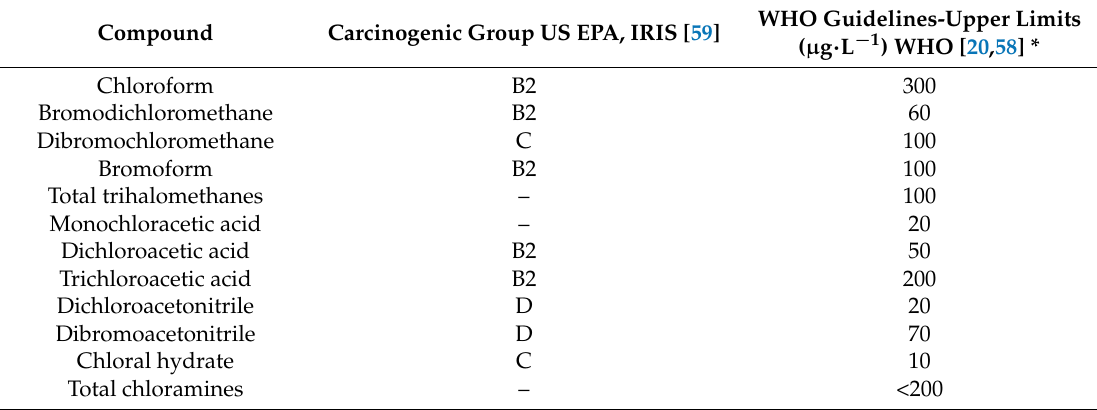
Table A2. Carcinogenic group classification and WHO guidelines for